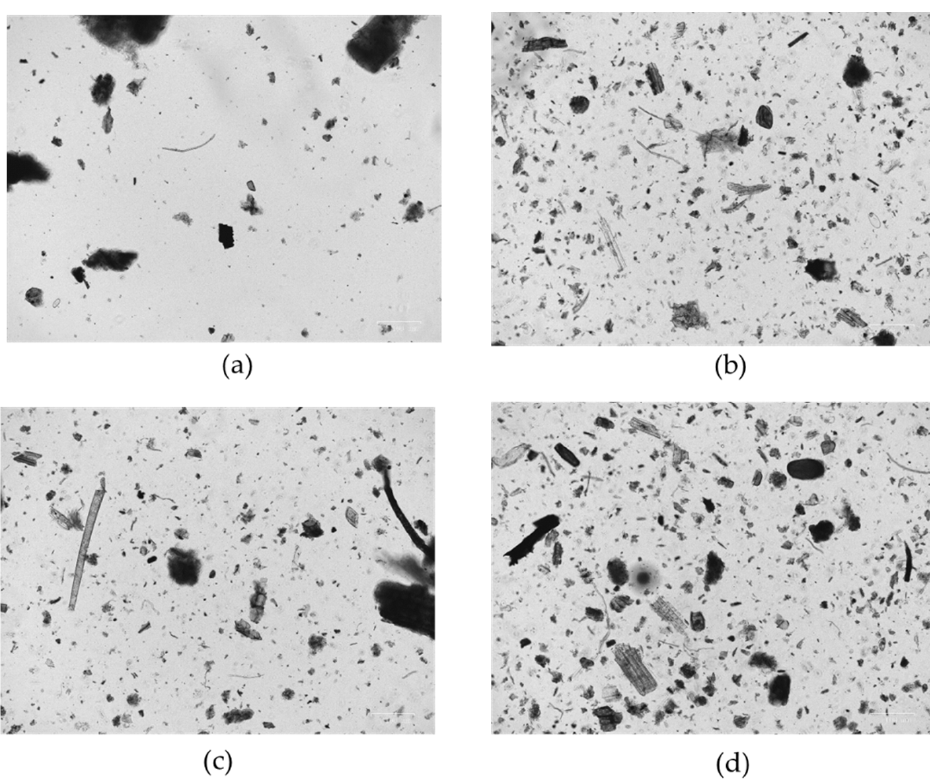
Figure 1. Microscopic analysis of M-peats: basic peat ( a ), after 6 months ( b ), after 16 months ( c ), and after 36 months ( d ) at 20 × magnification.